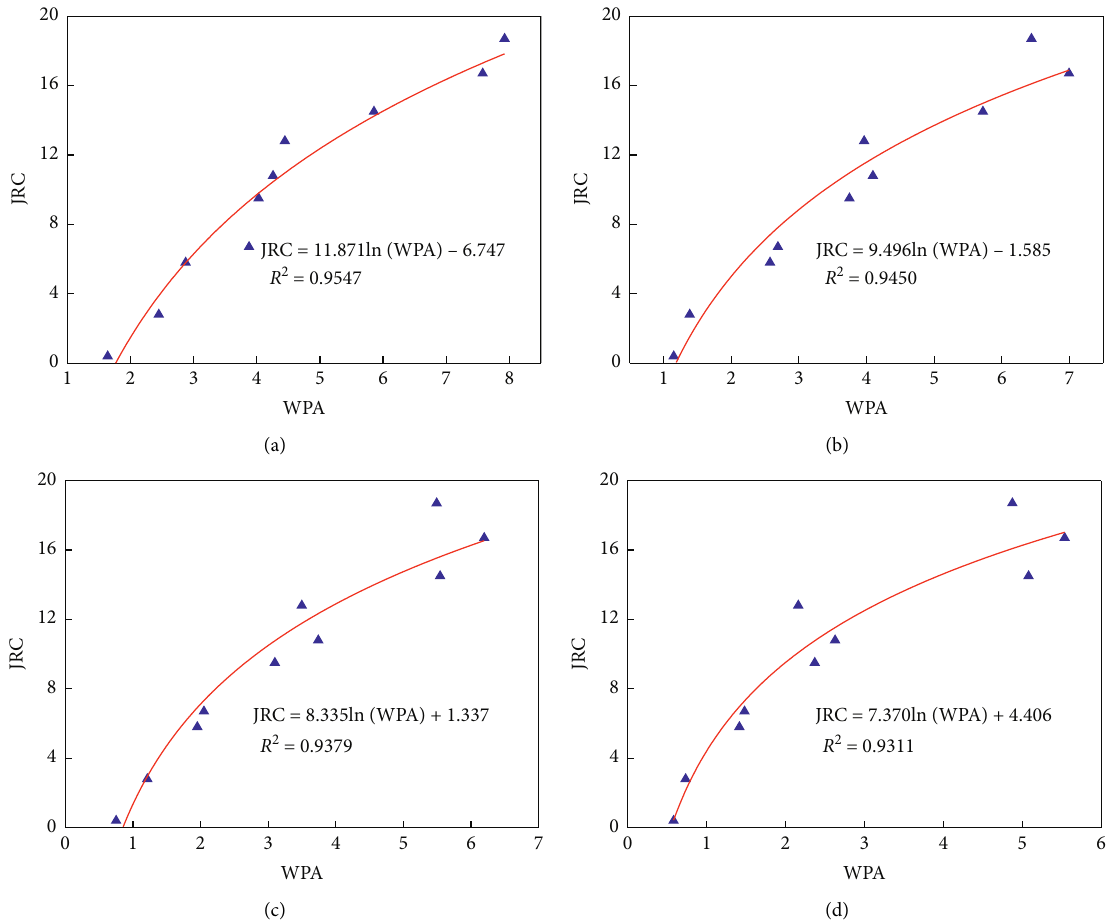
Figure 9: The functional relationships between WPA and JRC under different sampling intervals. (a) 1mm. (b) 2mm. (c) 4mm. (d) 10mm.